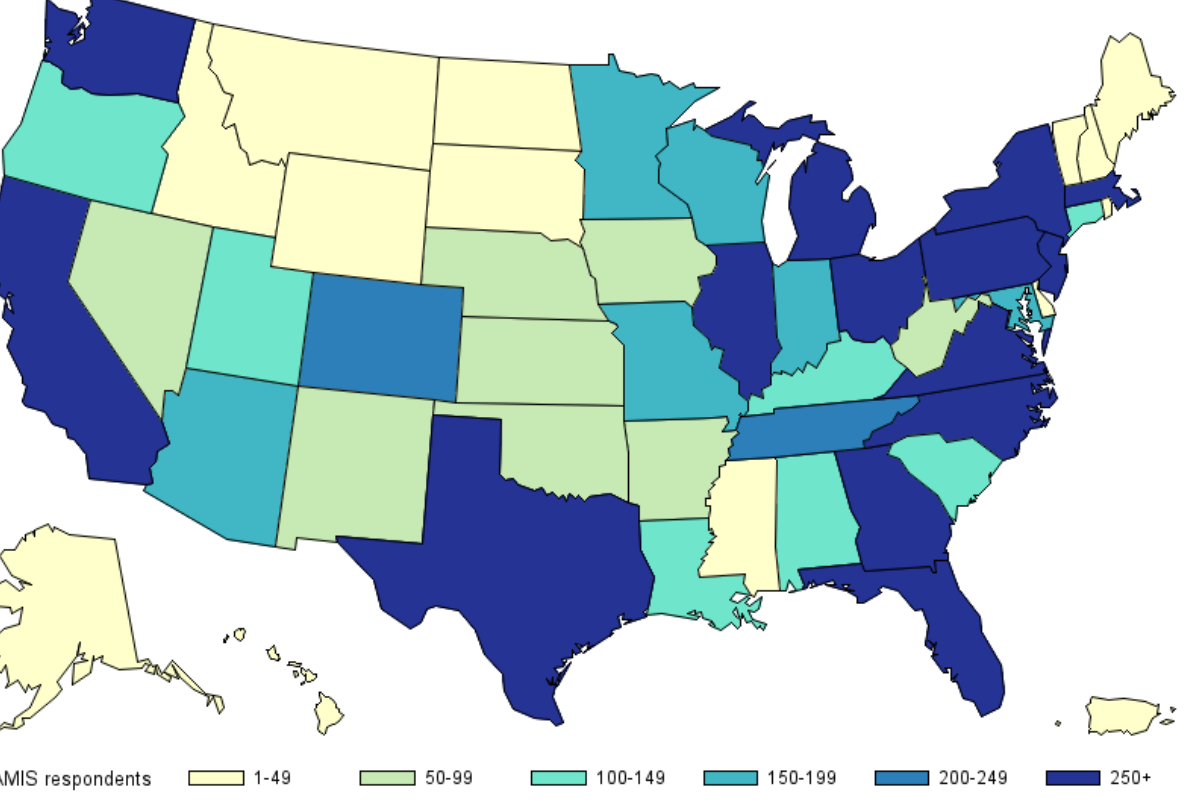
Figure 1. The number of men who have sex with men who participated in the American Men’s Internet Survey (AMIS) by state,